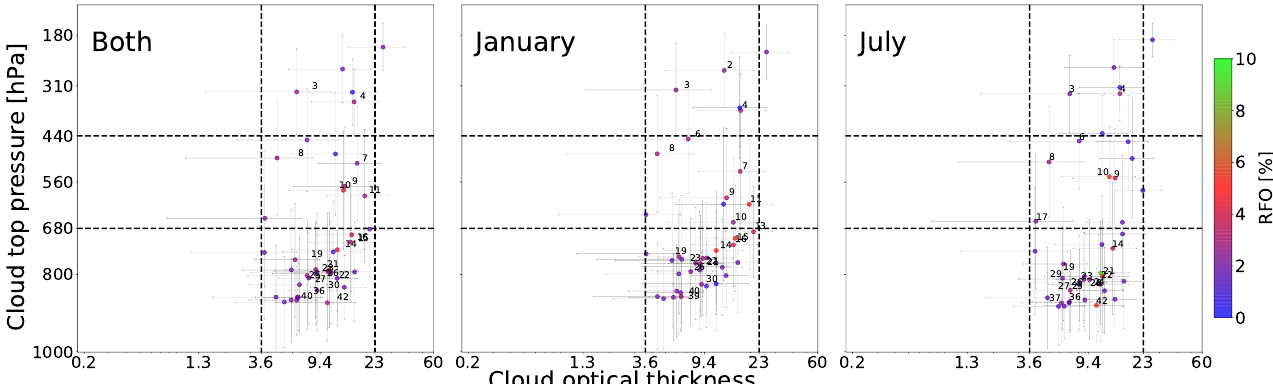
Figure 5. Distributions of cluster properties for AICCA 42 in COT–CTP space, where COT is cloud optical thickness (dimensionless) and CTP cloud top pressure (hPa). We show January and July 2003 (left), January only (center), and July only (right). Dots indicate mean values for each cluster and error bars the standard deviation of cluster properties. Data point colors indicate the relative frequency of occurrence (RFO) of each individual cluster in the dataset. Note that, in assigning cluster labels, we sort the clusters first on CTP and then on the global occurrence of the clusters within each 50 hPa pressure bin. Thus, small cluster numbers (e.g., #1) represent high-altitude cloud, and within a similar CTP range (e.g., 500 hPa–550 hPa), smaller numbers represent the more dominant patterns within the bin. For clarity, we show only the 21 clusters with the highest RFOs. For comparison, dashed lines divide the COT-CTP space into the nine regions corresponding to ISCCP cloud classes. AICCA 42 captures a greater variety of cloud types than do the ISCCP categories, with most of the clusters at low altitude (high CTP). January and July panels are similar, indicating that AICCA 42 adequately captures seasonal variation in cloud